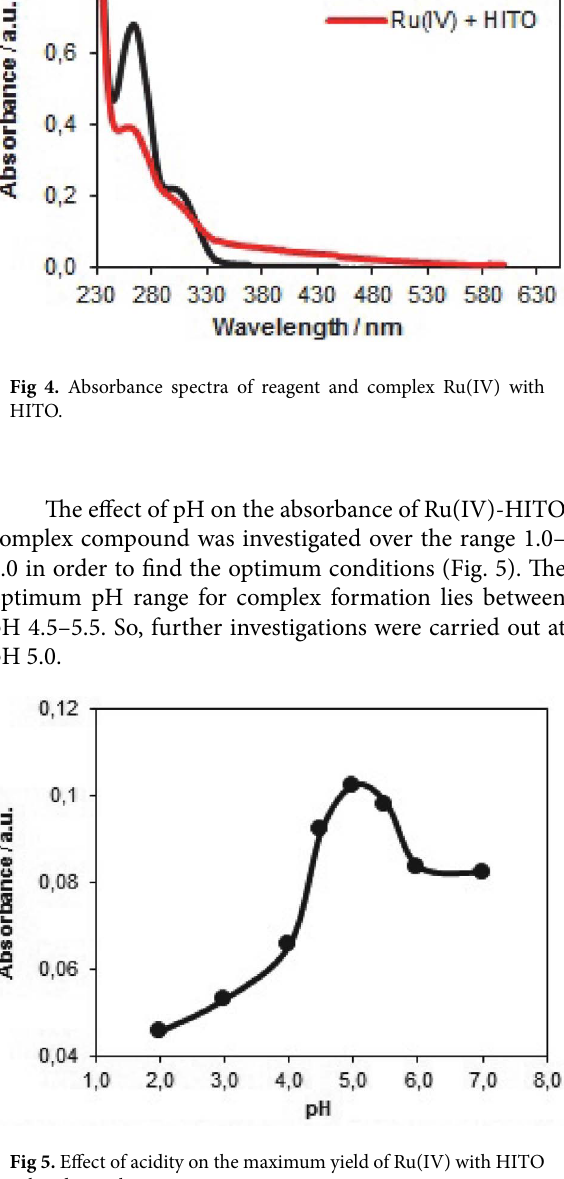
Fig 5. Effect of acidity on the maximum yield of Ru(IV) with HITO colored complex.